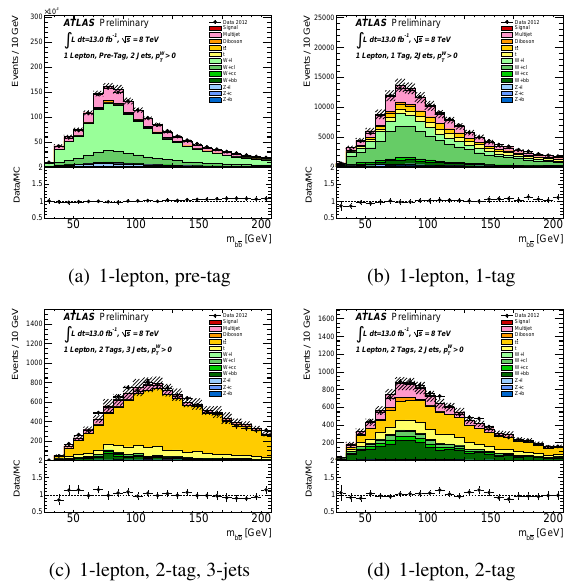
Figure 1. The m distributions for the signal (bottom right) and b ¯ b control (top and bottom left) regions for the 1-lepton selection integrated over the bins of p V [9]. The error bands indicate the T size of the combined statistical and systematic uncertainty before the profile likelihood fit. See text for details of the definition of the control